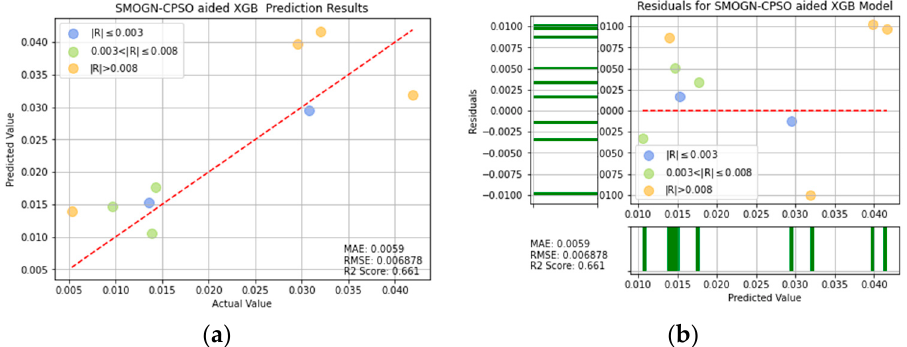
Figure 22. SMOGN-CPSO-XGB prediction results: ( a ) comparison of actual and predicted precision values, and ( b ) residual plot.